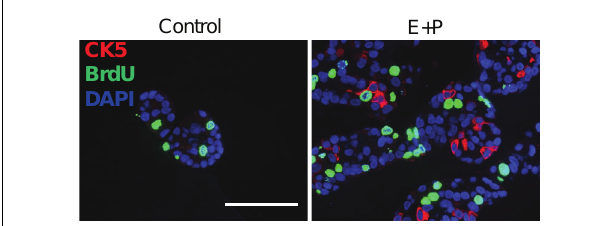
FIGURE 4 | Hormone treatment induces basal-like Cytokeratin 5 (CK5) expression in a subset of luminal breast cancer cells. ER + PR + T47D cells were incubated with ethanol (Control) or a combination of estrogen and progesterone (E + P). Cells were also incubated in BrdU (green) to assess proliferation. Following E + P treatment, a subset of cells expressing CK5 (red) is expanded, that has little or no proliferative activity. Scale: 100 μ